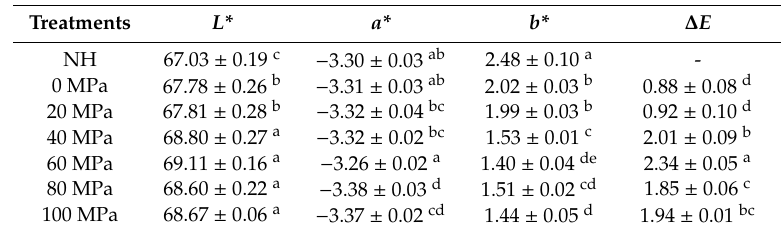
Table 3. Mean ( ± SD) values of lightness ( L* ), redness ( a* ), yellowness ( b* ), and total color di ff erences ( ∆ E ) of the NH (non-homogenized) sample and high-pressure homogenization (0–100 MPa) processed lily pulps.